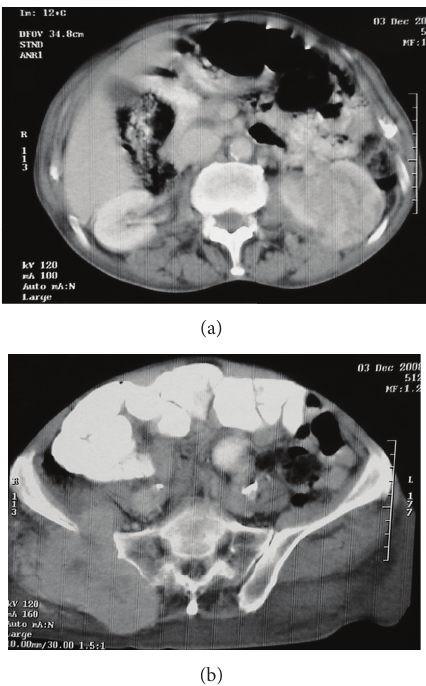
Figure 3: Histopathological evaluation: (a) biopsy from renal mass presenting the characteristic features of renal cell carcinoma (hematoxylin & eosin) and (b) renal cell carcinoma metastasis to gluteus muscle (hematoxylin &